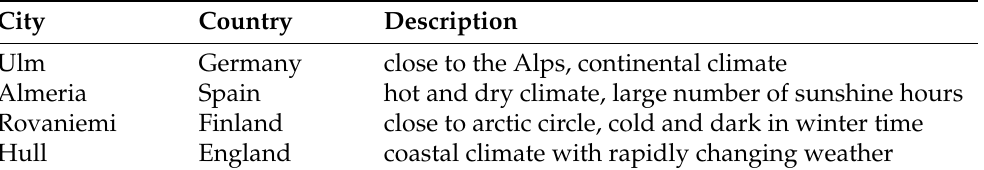
Figure 4. Other input factors from Ulm from 1 December 2019 to 30 November 2020. Table 1. Locations considered in the case study.